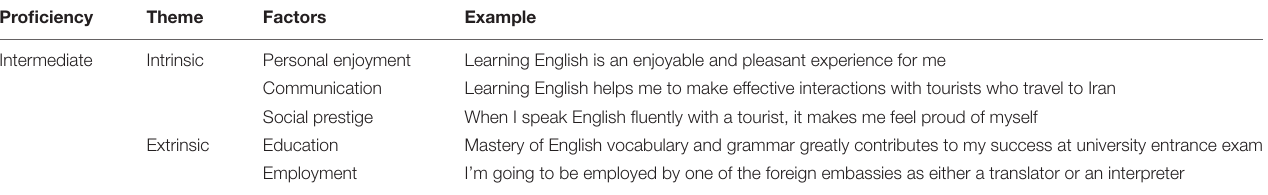
TABLE 6 | Motivational factors influencing intermediate EFL learners. Proficiency